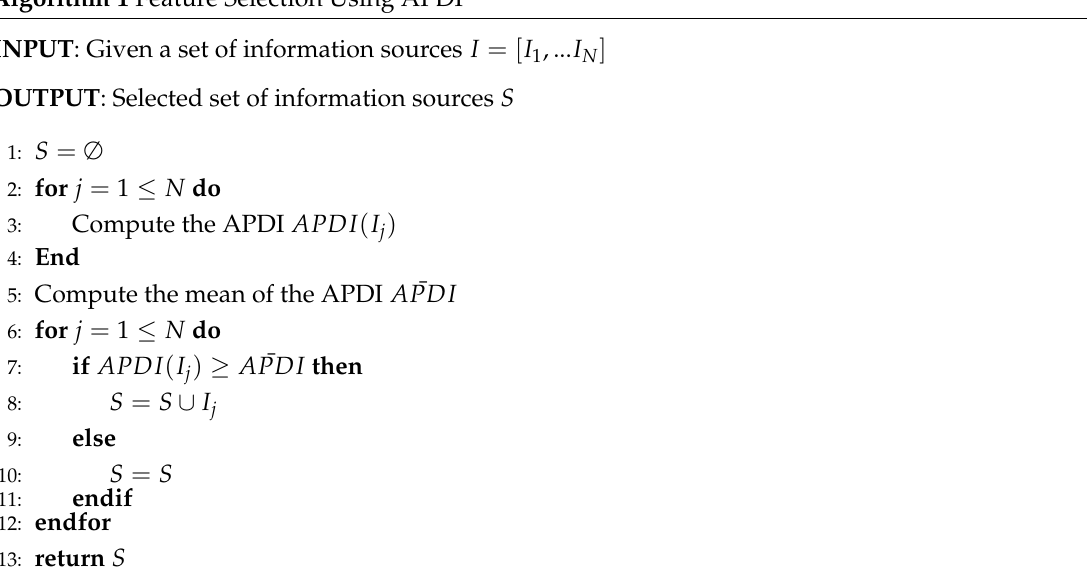
Algorithm 1 Feature Selection Using APDI